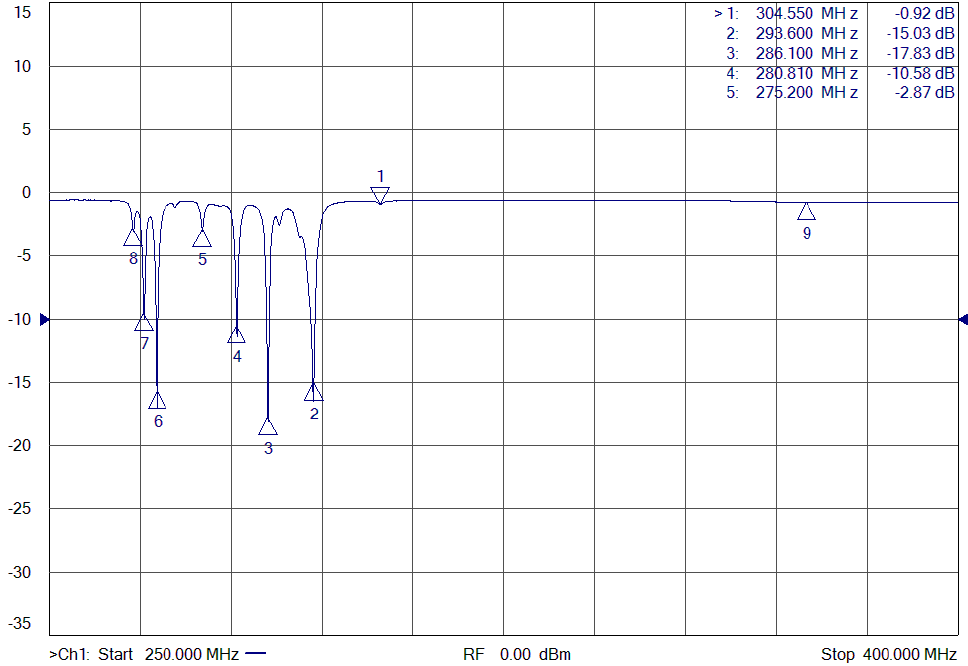
Figure 11 . Full spectrum of a single outer birdcage-like structure in absence of capacitors on the inner and opposing outer structures (frequency sweep for 250 to 400 MHz).